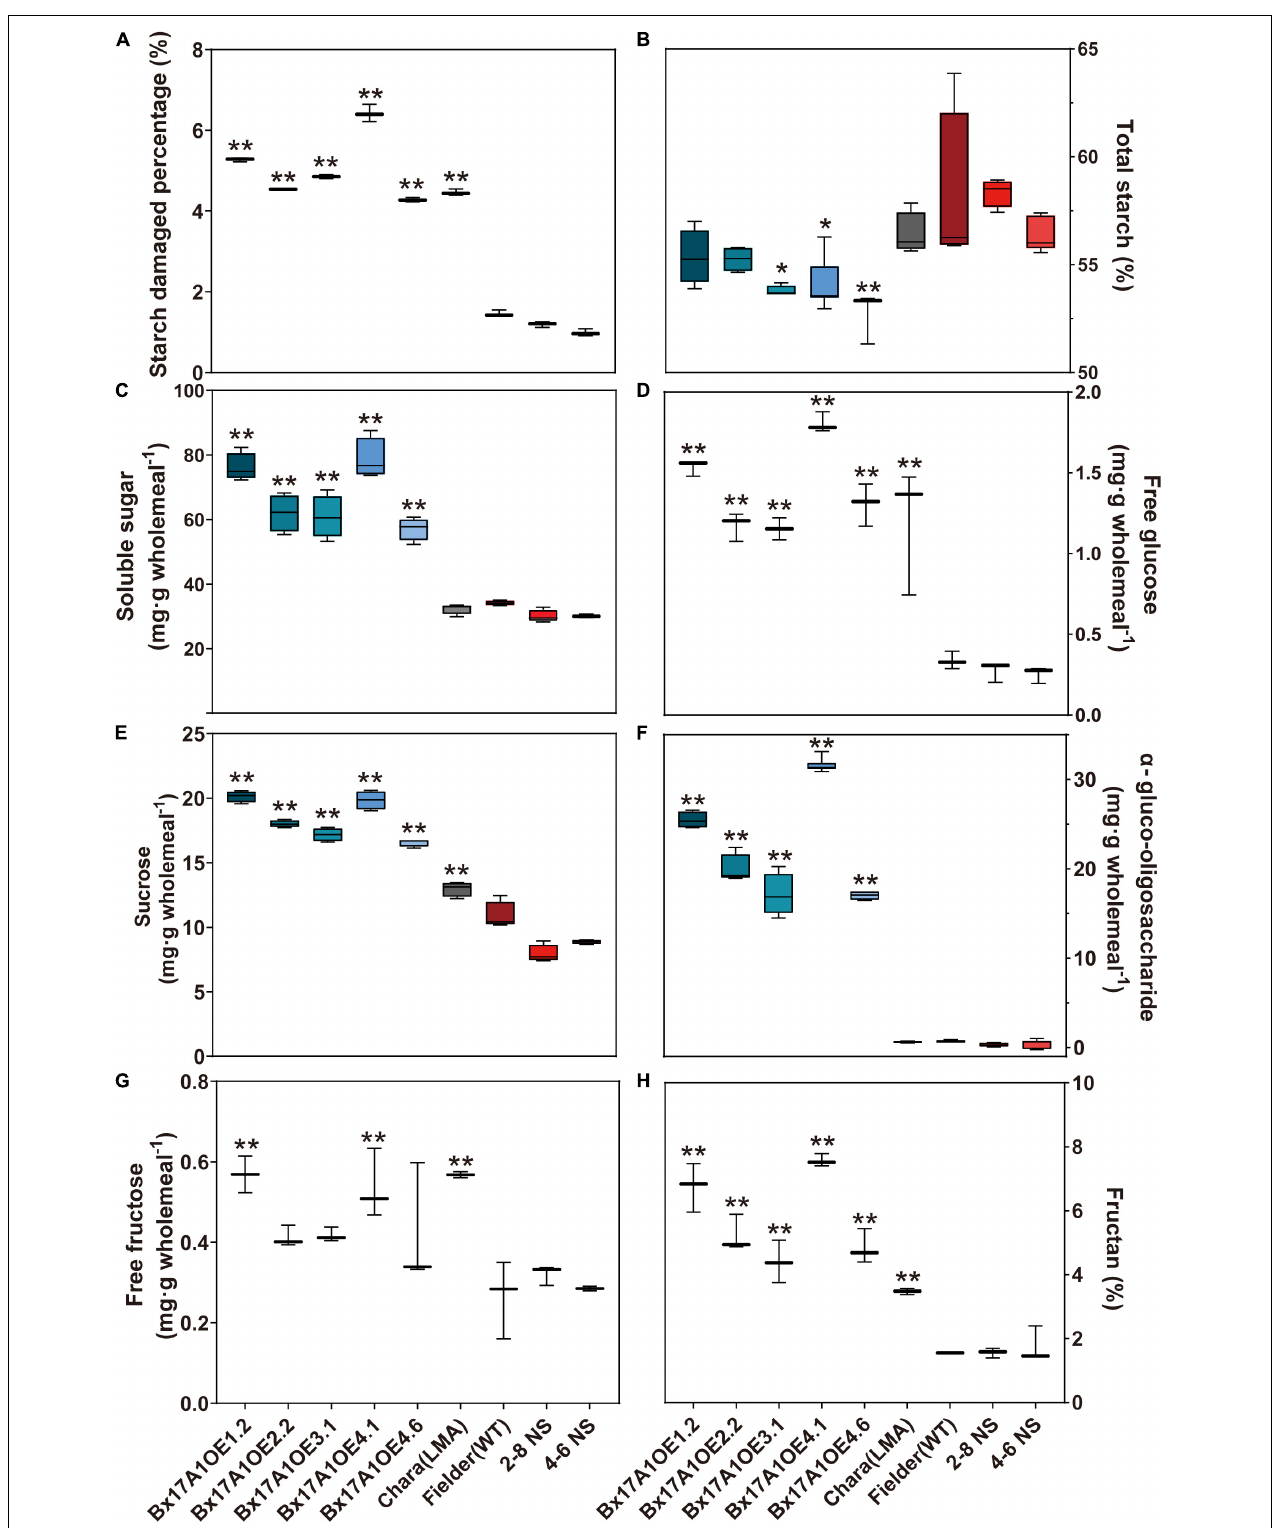
FIGURE 4 | Effect of TaAMY1 overexpression carbohydrate composition in mature grains. Damaged starch (A) , starch (B) , and fructan content (H) are expressed in percentage of wholemeal flour. Total soluble sugar (C) , free glucose (D) , sucrose (E) , α -gluco-oligosaccharide (F) , and free fructose (G) are expressed in milligramme per gramme wholemeal. p -values are indicated as follows * p < 0.05 and ** p < 0.01. Error bars represent Standard Error of three replicates.